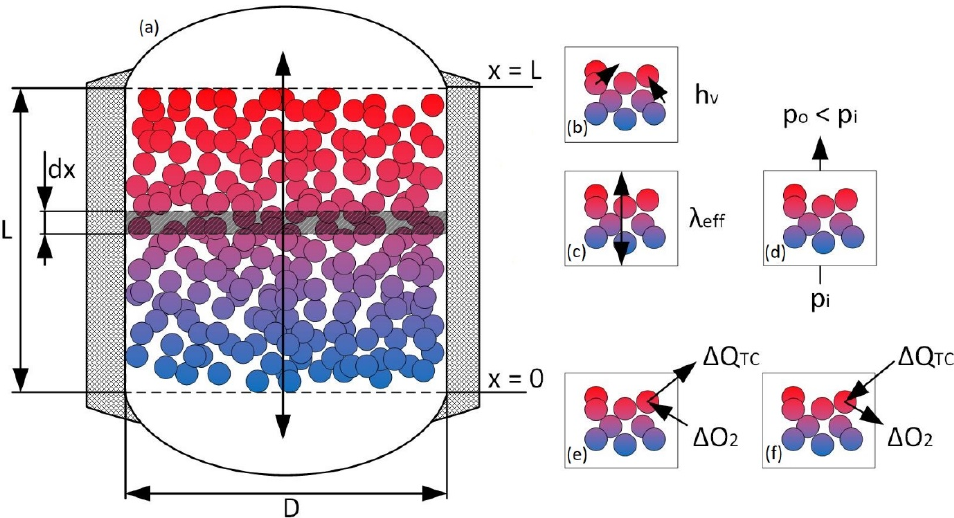
Figure 2. Schematic visualization of the TES interior ( a ). The colored particles form a natural porosity with a void fraction (white background) of about 40%. Furthermore, the dimensions are displayed for a better understanding of the boundary conditions. ( b ) effective volumetric heat transfer coefficient between the heat transfer media (air) and the solids. ( c ) effective bed conductivity along the storage axis based on thermal conductivity and radiation. ( d ) pressure drop due to the porous media flow through the packed bed. ( e , f ) reactive heat ∆ Q TC due to oxidation and reduction of the solid redox material.